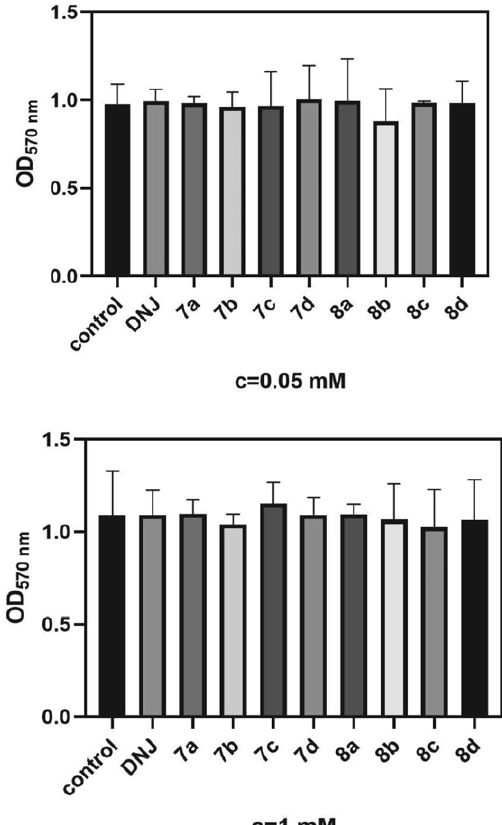
Figure 4. Effect of glycosidase inhibitors on B16F10 cells growth. Each bar represents the mean (±SD, n = 6). P > 0.05 comparing with